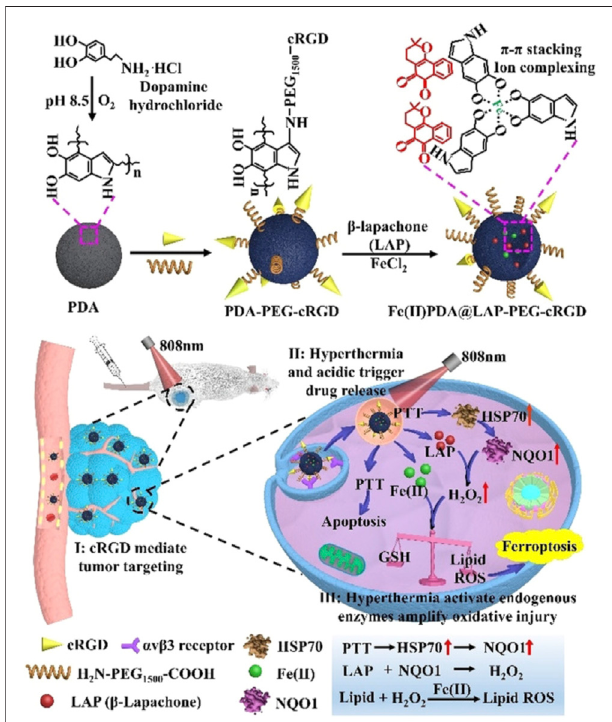
FIGURE 5 | Synthesis scheme of the Fe 2+ PDA@LAP-PEG-cRGD nanomaterialandmechanismofPTT/FBT forcancer.Adapted fromXueet al., (2021) Copyright @ 2021